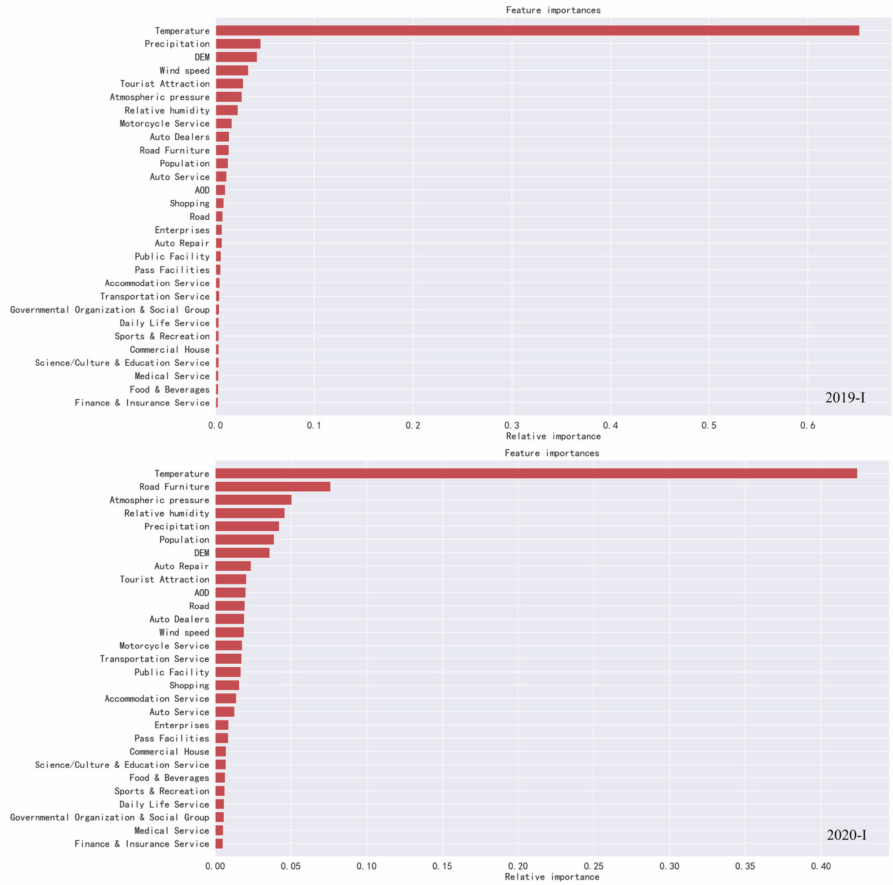
Figure 3. Feature importance during 2019-I and